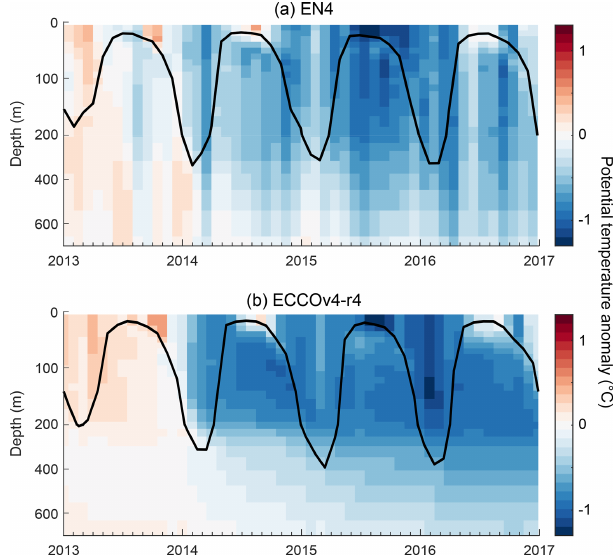
Figure 3. Potential temperature anomaly over depth, relative to the 1992–2015 monthly climatology (colour; ◦ C), averaged over the cold blob region in (a) EN4 observations and (b) ECCOv4-r4. The MLD is also shown (black line, m). Note the non-uniform spacing of the vertical